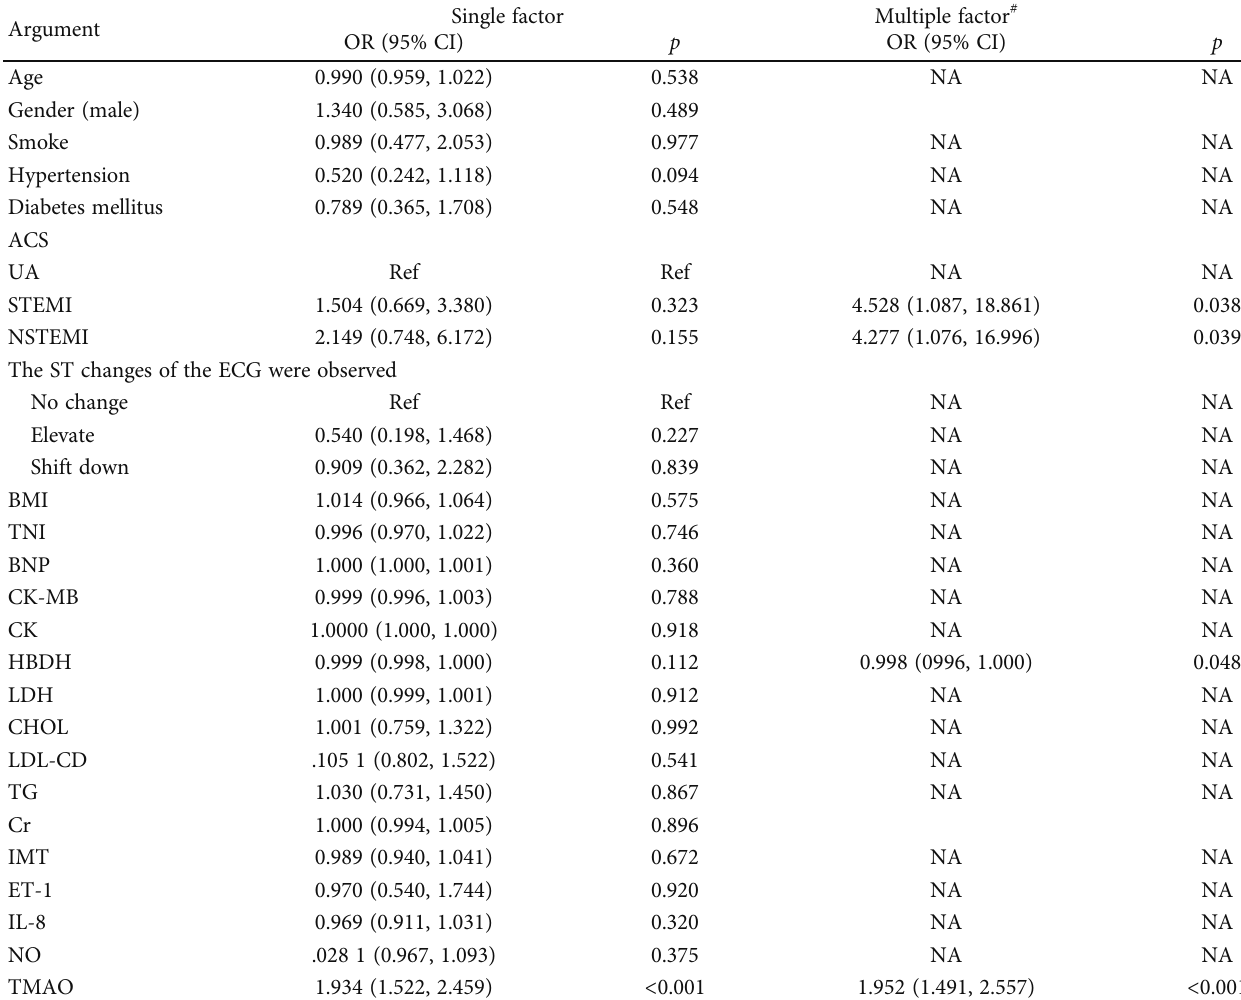
Table 4: The logistic regression analysis of the factors associated with severe